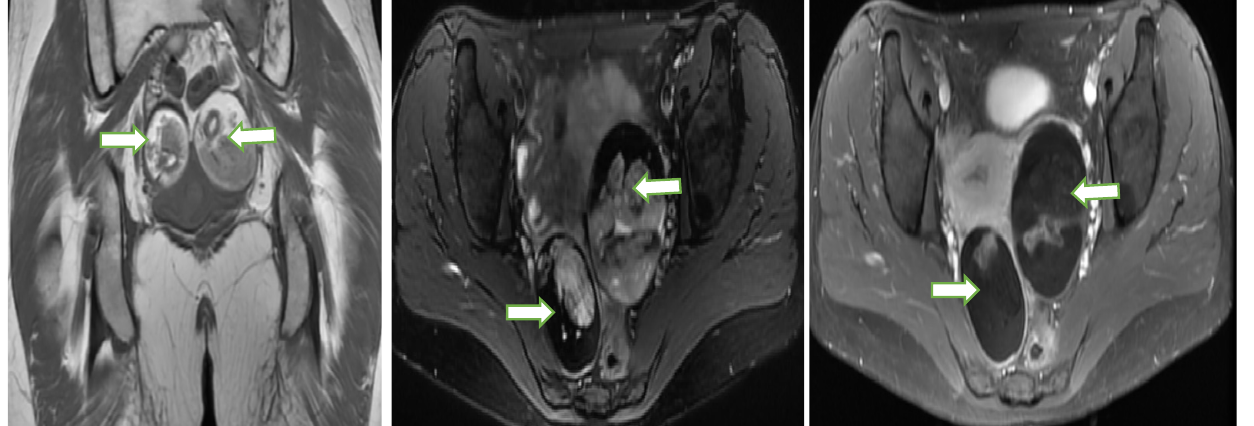
Figure 9. Coronal T1W ( a ), Axial T2W with fat saturation ( b ) and axial post contrast T1W ( c ) MR images through the pelvis in a 33 year old lady with abnormal vaginal bleeding show bilateral well circumscribed fat containing non-enhancing adnexal masses consistent with ovarian dermoids. Subsequent follow up ultrasound for the lesions show no significant interval changes in keeping with the benign nature of the